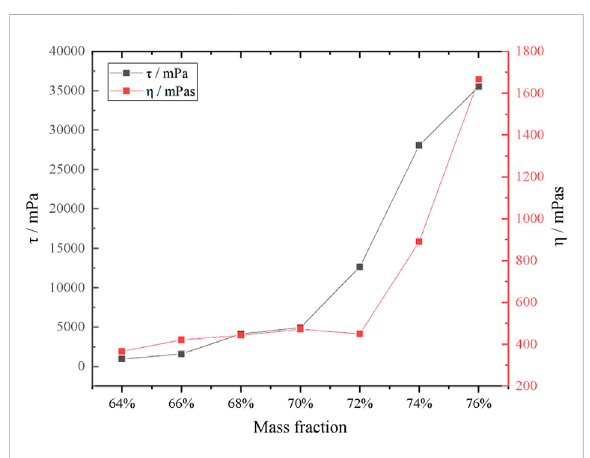
FIGURE 8 Relationship between the shear stress and viscosity of slurry with